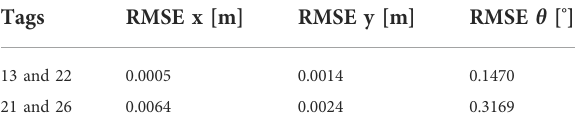
TABLE 1 Root-mean-square error from the ground truth ’ s pose tests. Tags